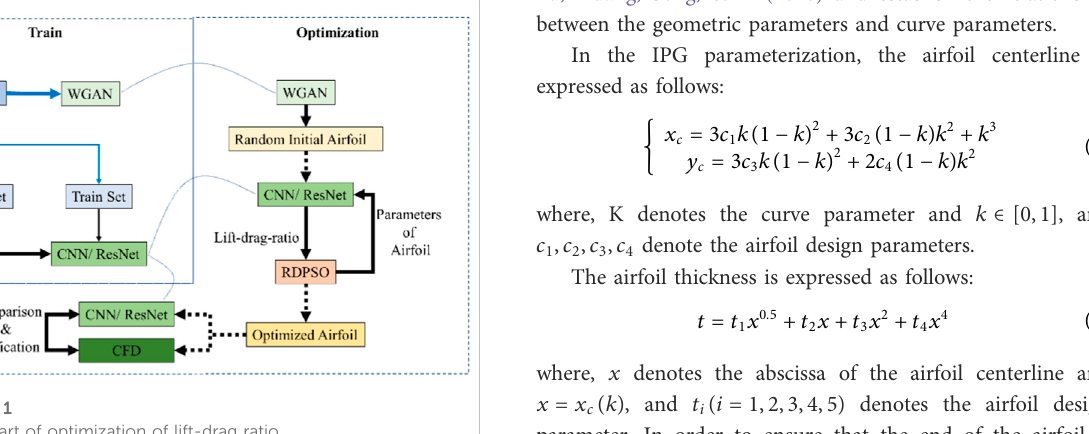
FIGURE 1 Flow chart of optimization of lift-drag